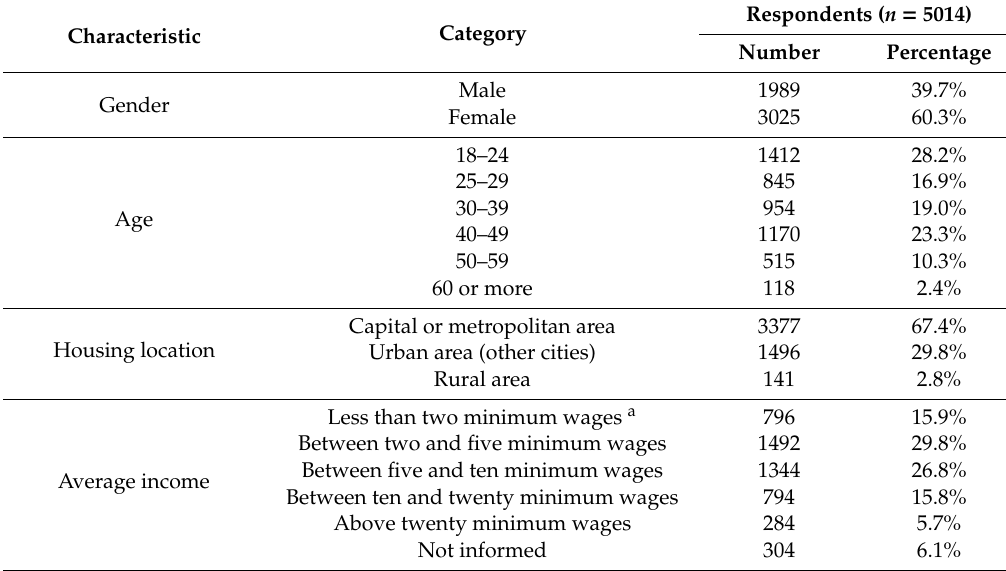
Table 3. Sociodemographic characteristics of the studied